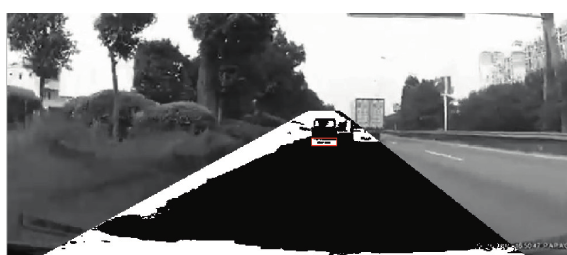
Figure 5: Vehicle shadow area